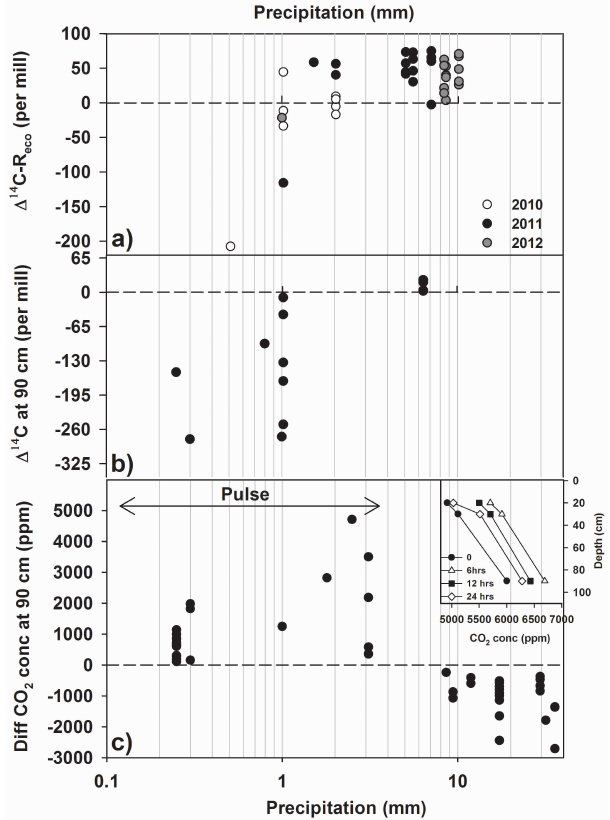
Figure 5. Radiocarbon content ( 1 14 C, per mill) of (a) R eco and (b) pore space CO 2 at 90cm depth within 24h of a precipitation event vs. precipitation amount (mm). (c) Difference in pore space CO 2 concentration at 90cm depth before and after a precipitation event vs. precipitation amount (small insert shows CO 2 concentra- tion along the soil profile before and 6, 12 and 24h after a precipi- tation